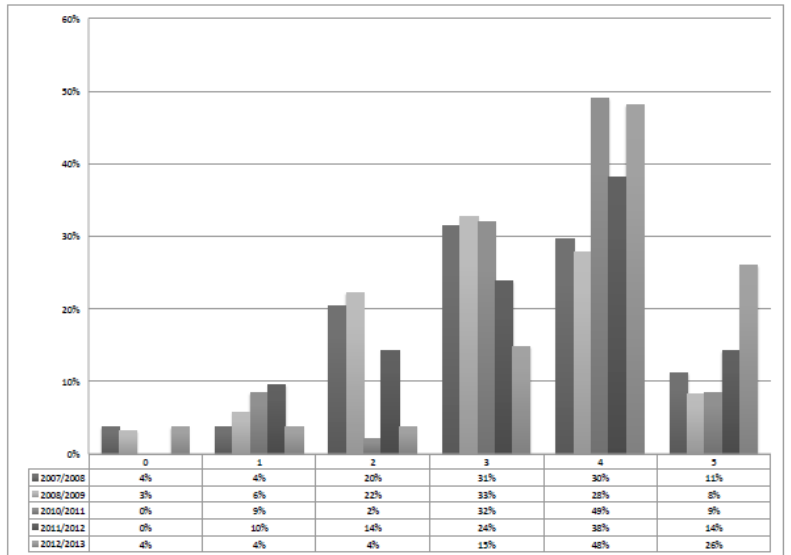
Figure 5. Laboratory assignments require a solid understanding of the Java programming language